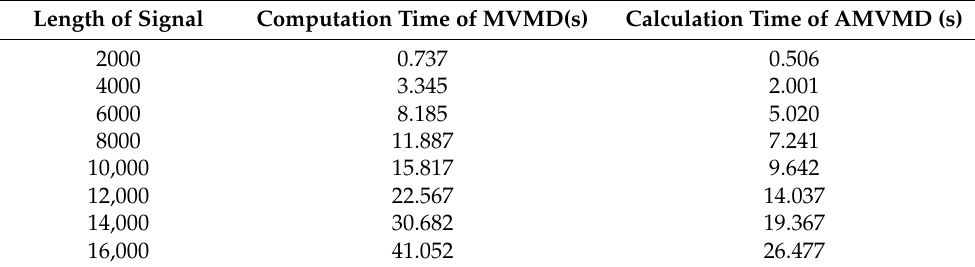
Table 1. Comparison of operation time.